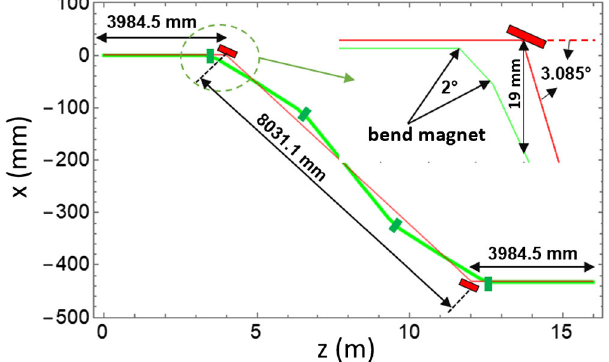
FIG. 6. A schematic of the cooling system. The red line shows the light path, and the two small red boxes are the off-axis parabolic mirrors. The green line shows the electron path, and the four green boxes are bending magnets. The quadrupole lenses used in the electron beamline are not shown. The inset shows the details of the mirror separation from the electron beam trajectory. A small initial offset of the light trajectory seen there is due to the 1.4-mm electron beam orbit offset in the wiggler (see Fig. 3).